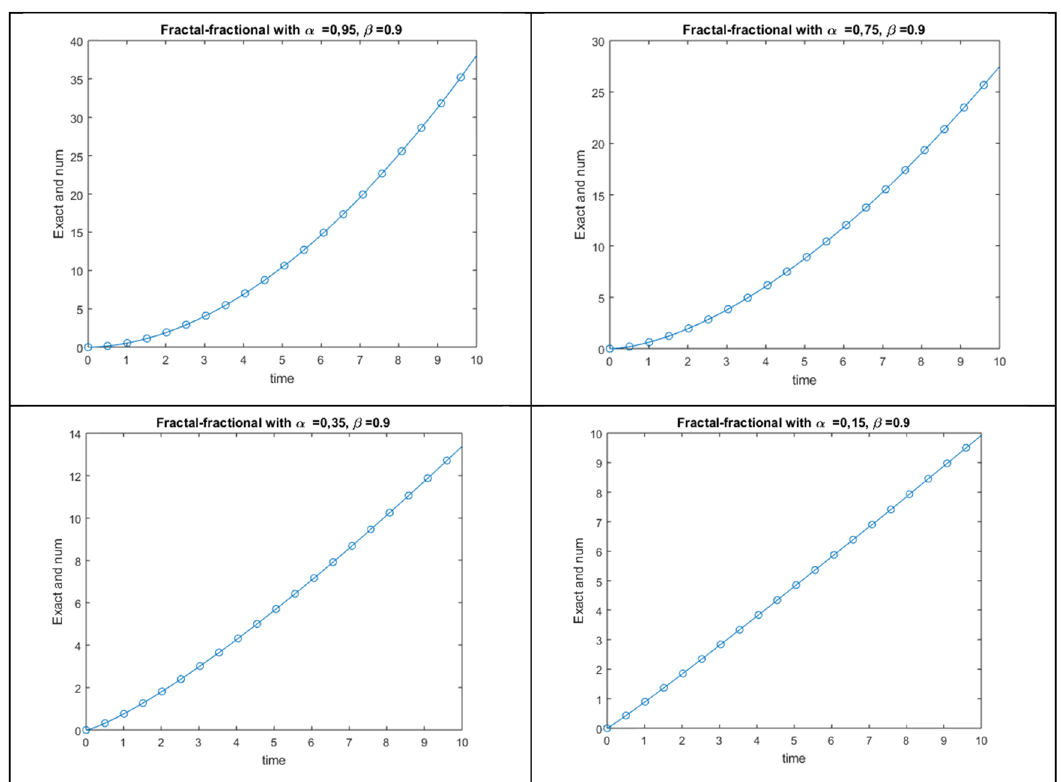
Figure 1: Numerical solution with the power - law